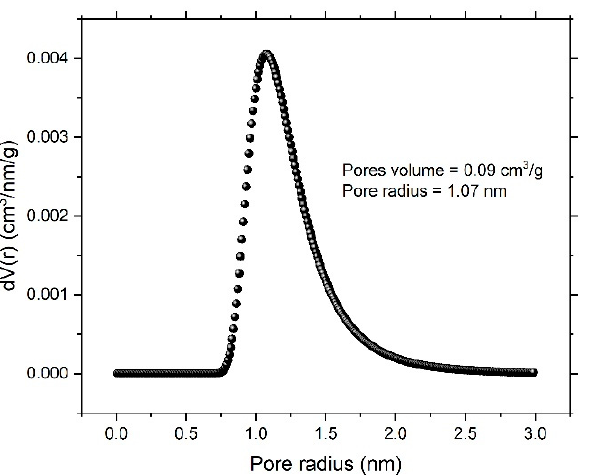
Figure 5. Pore-size distribution curve obtained according to the Dubinin–Astakhov (DA) method.